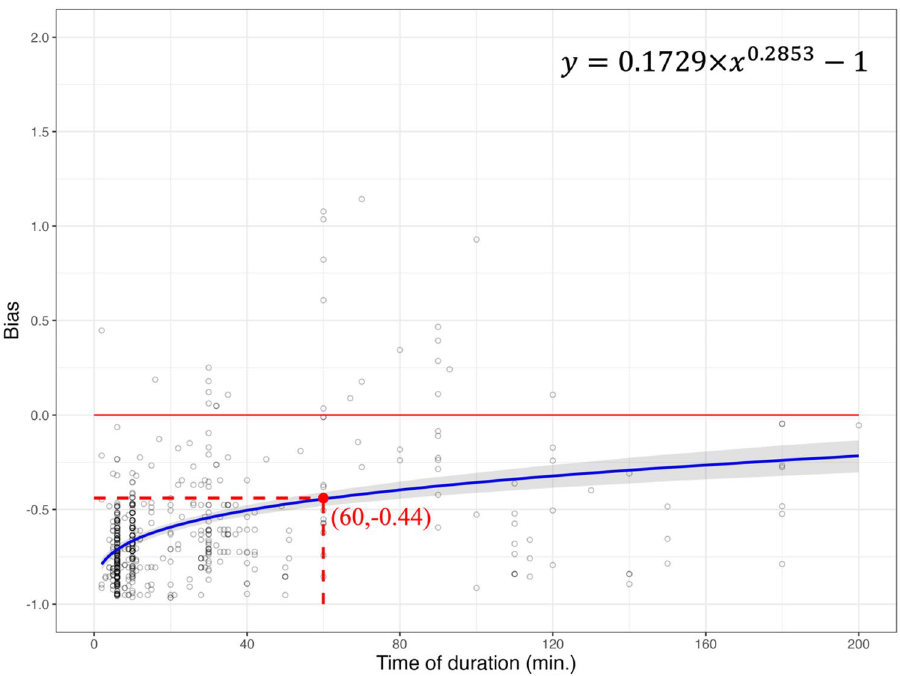
Figure 2. The relationship of duration on eBird checklists and bias. The power function (formula on the top right) estimated the non-linear relationship between duration and bias (blue solid line). Bias was derived from the results of observed species richness in eBird and average observed species richness from BBS (black circle). Where bias = 0 (red solid horizontal line) indicates no differences among observed species richness from eBird and average observed species richness from BBS, indicating eBird could record an average of 100% of the BBS species